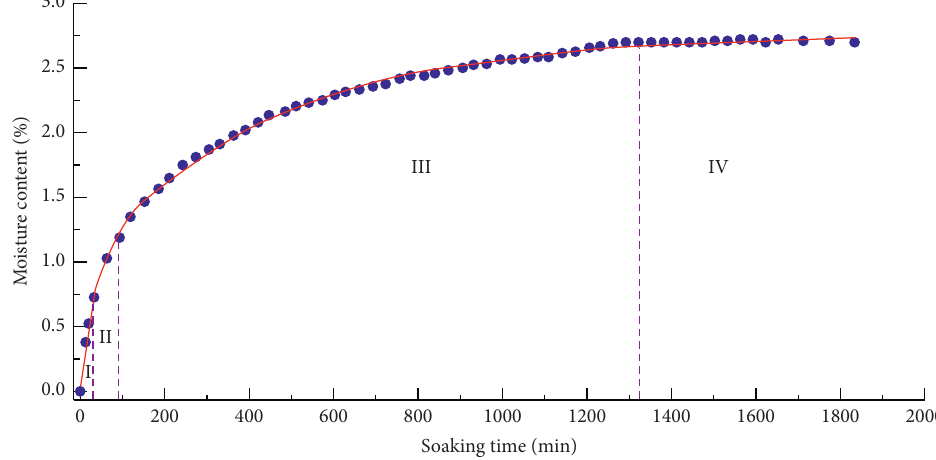
Figure 2: Fitting curve of the water content of sandstone and soaking time. Table 1: Relationship between water content of sandstone and soaking